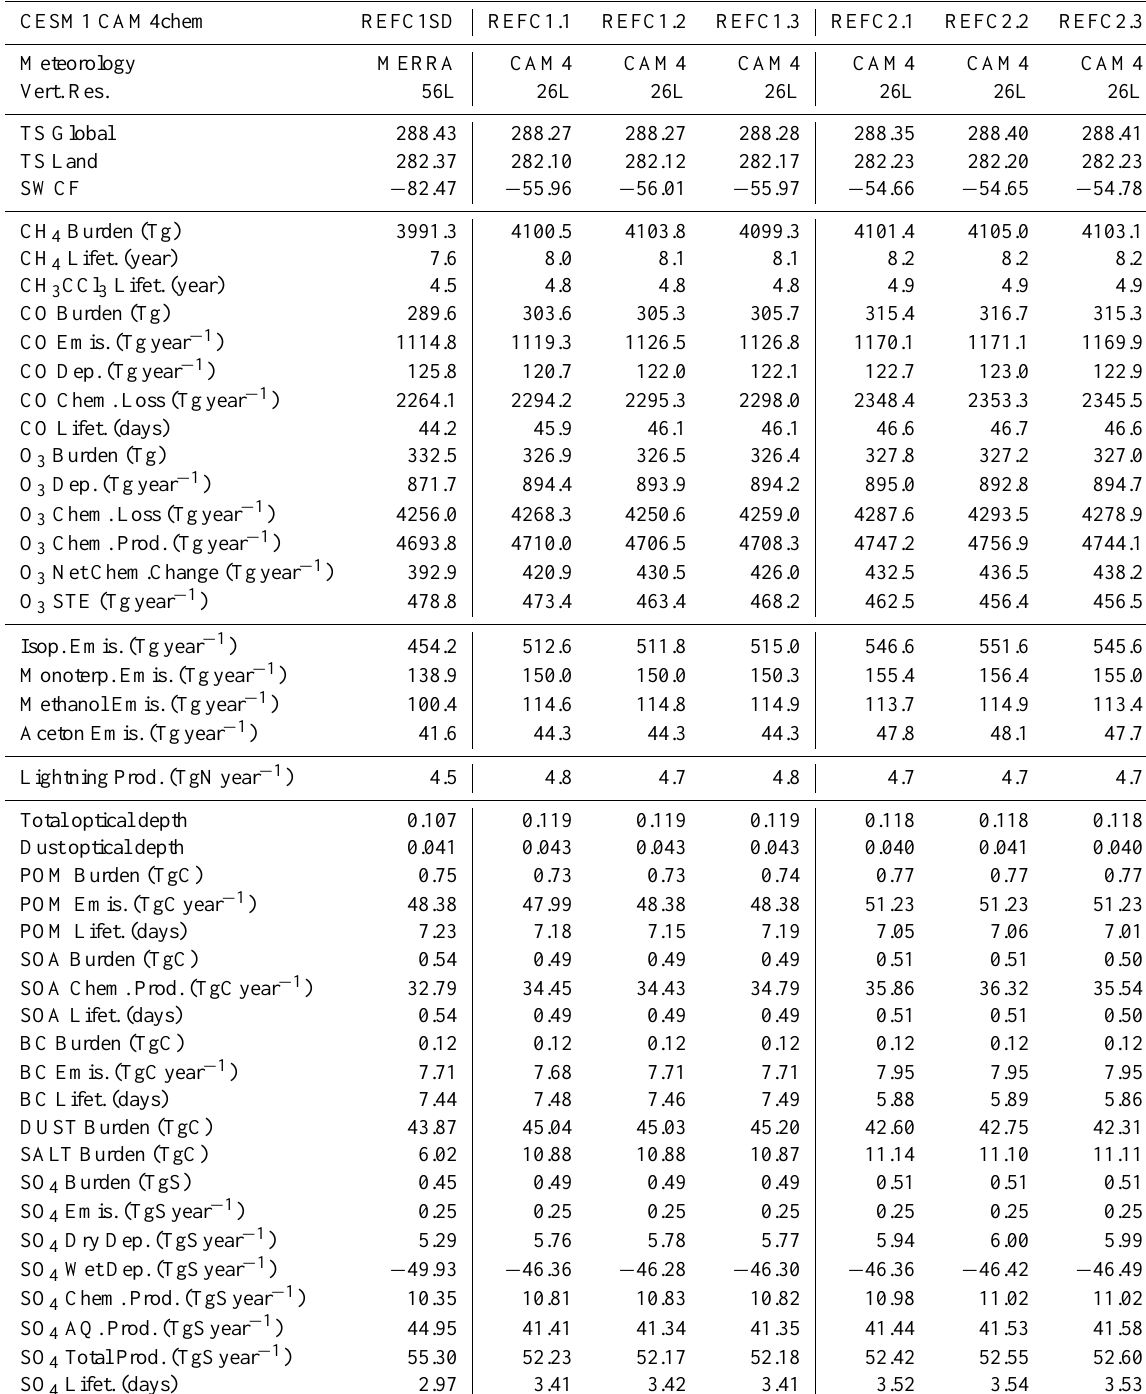
Table 1. Overview of global diagnostics for different experiments, averaged between 1995 and 2010. Lifetimes and burdens are calculated for the troposphere defined for regions where ozone is below